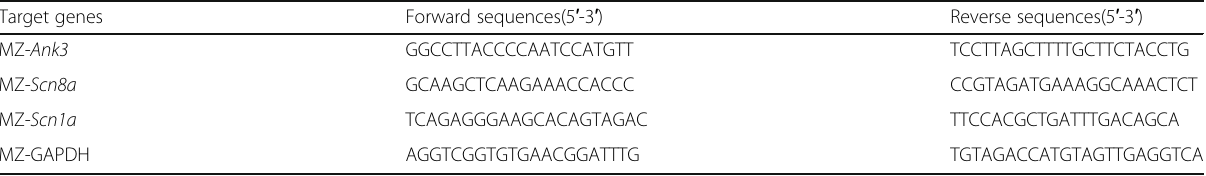
Table 1 Sequences of Forward and reverse primers for real-time PCR Target genes Forward sequences(5 ′ -3 ′